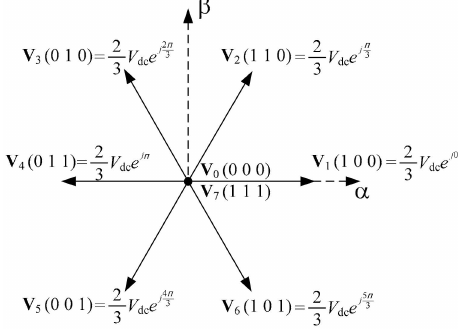
Figure 2. Voltage vector